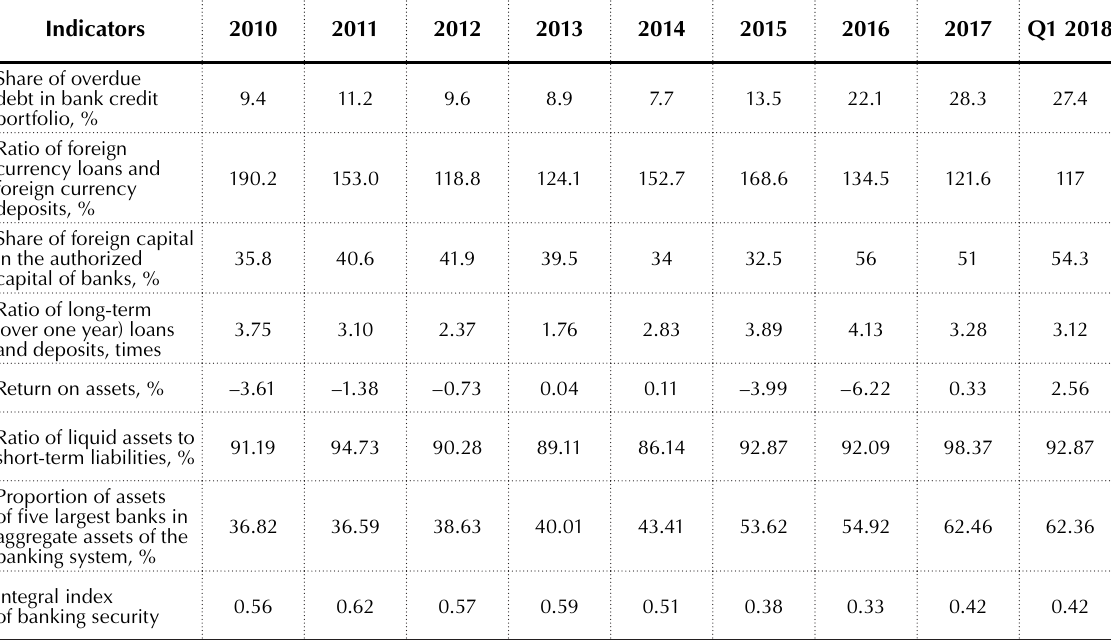
Table 4. The integral index of banking security of Ukraine for 2010–2017 and Q1 2018